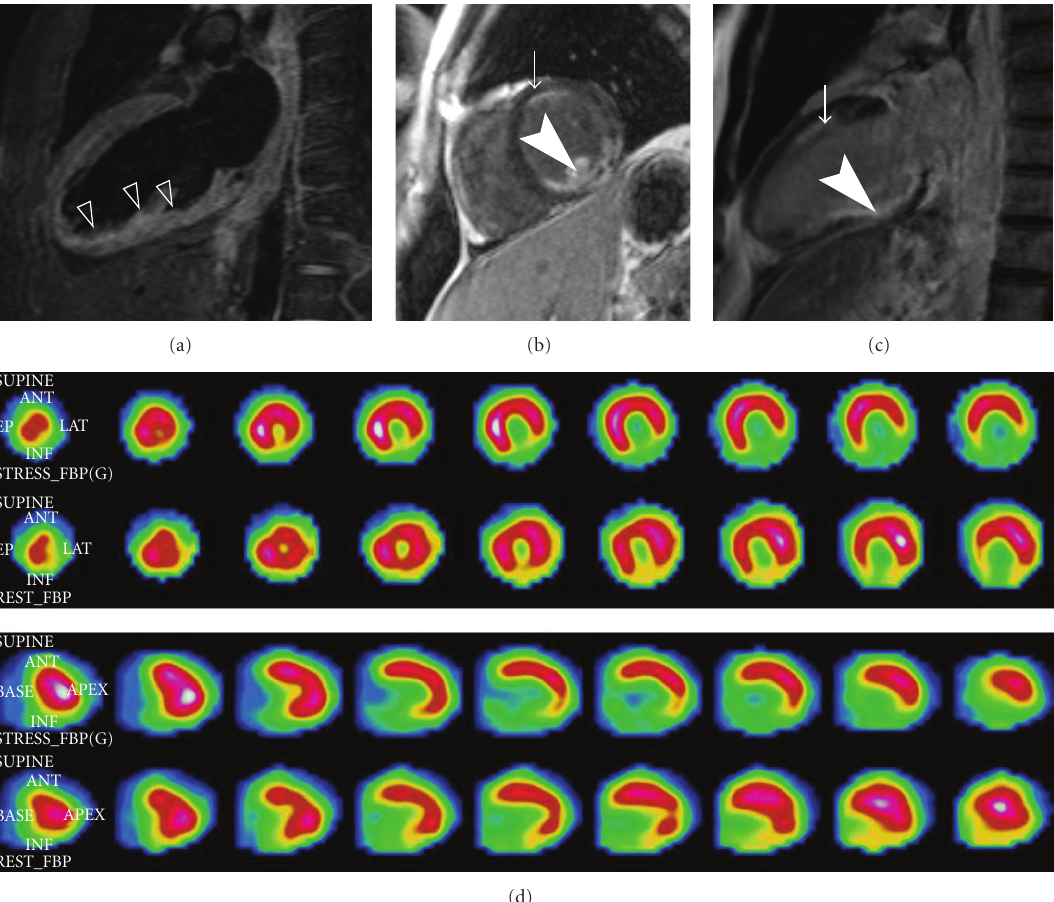
Figure 2: Black blood T2 images (T2 weighted short inversion-time, inversion-recovery (STIR) breath hold pulse sequences) suggested myocardial oedema (arrowheads) strictly in the inferior wall (Figure 2, Panel (e)). Gadolinium-enhanced images (Inversion Recovery turboFLASH 3D short axis and long axis sequences) demonstrated transmural late enhancement of the inferior wall (arrowheads) associated with late microvascular obstruction (Panel (f) and (g)). Furthermore, these sequences showed a subendocardial delayed enhancement area (arrows) which was located in the anterior wall at mid-ventricular level in favour of a limited necrosis (Panel (f) and (g)). Myocardial perfusion scintigraphy with thallium-201 suggested hypoperfusion in the inferior and lateral walls during stress but did not detect at rest any hypouptake in the anterior wall (Panel